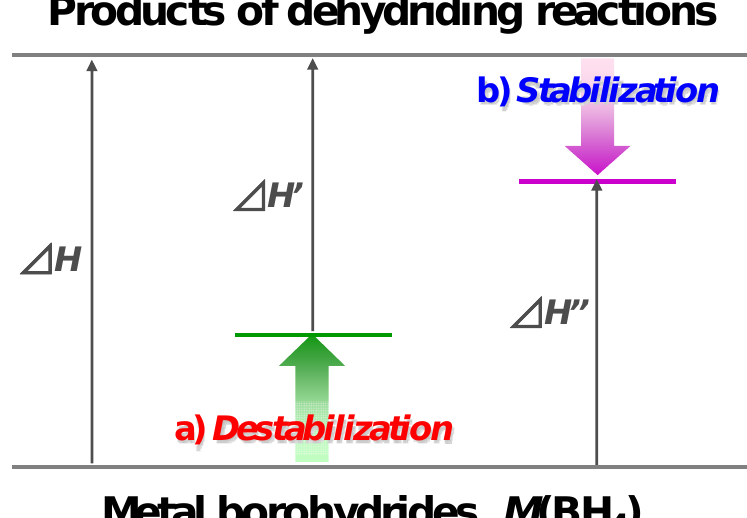
Figure 3. Schematic illustration of two main approaches to tailor the thermodynamic stabilities of metal borohydrides M (BH stabilization of dehydrogenation